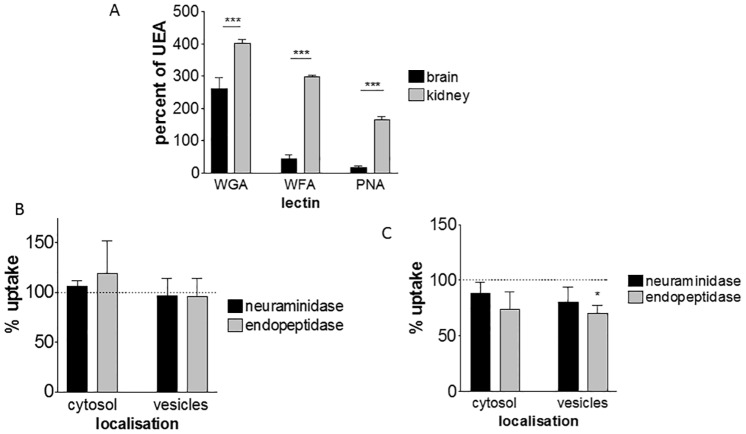
Effect of the endothelial glycocalyx on nanoparticle internalisation.(A) Binding profile of lectins WGA, WFL and PNA on brain and kidney endothelium. Binding was standardised as a percentage of UEA (standard endothelial marker), showing the mean ± SEM from 3 independent experiments (ANOVA and Tukey’s multiple comparison test, *** P<0.001). Effect of partial removal of glycocalyx (with neuraminidase or endopeptidase) on nanoparticle uptake into cytosol or vesicles, of brain endothelium (B) or kidney endothelium (C), compared with untreated cells (= 100%). (Data shown are mean ± SEM from 3 independent experiments, paired t-test, * P<0.05).